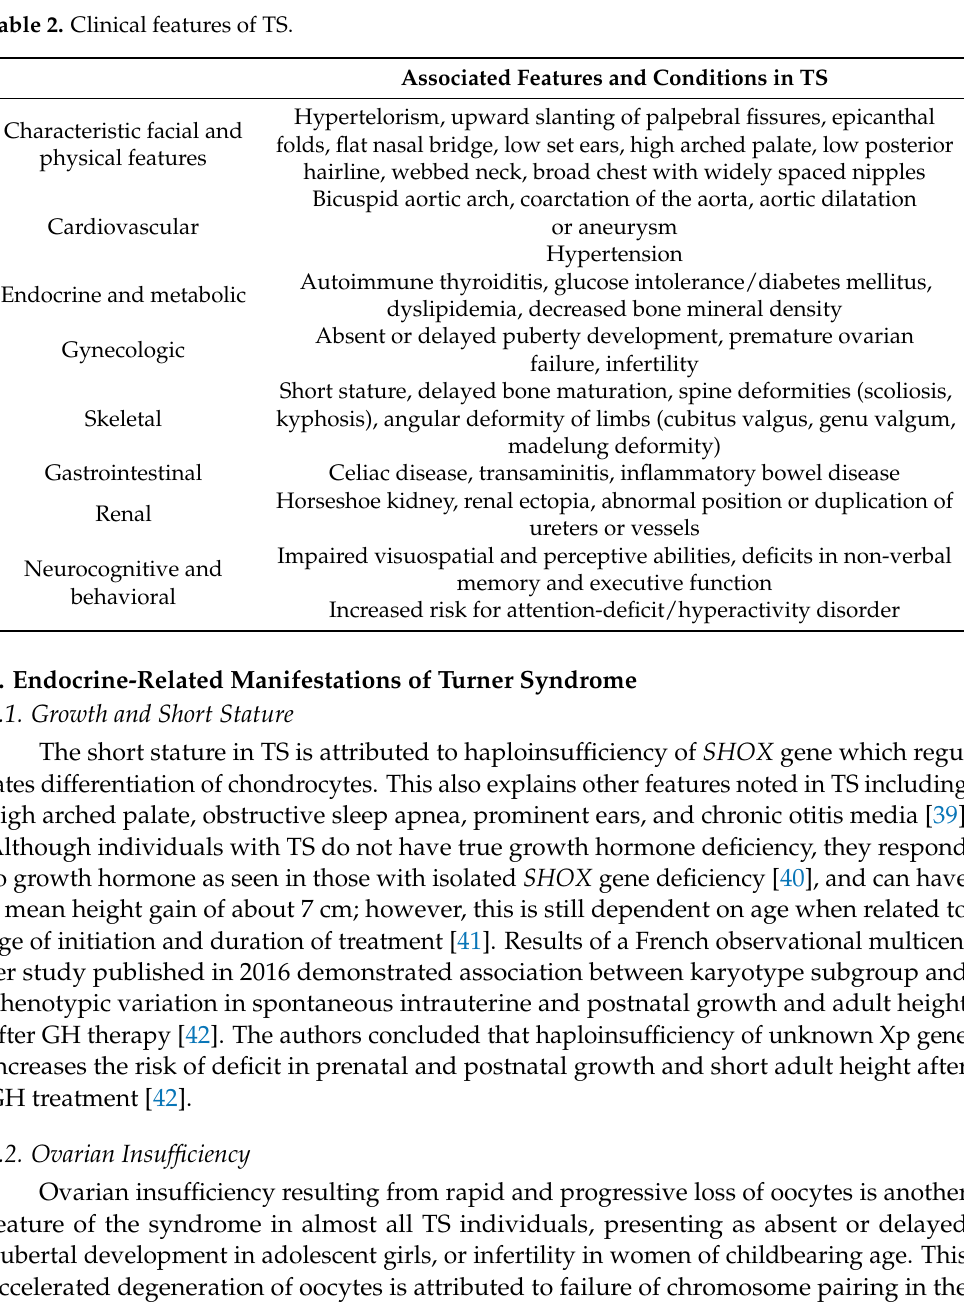
Table 2. Clinical features of TS.